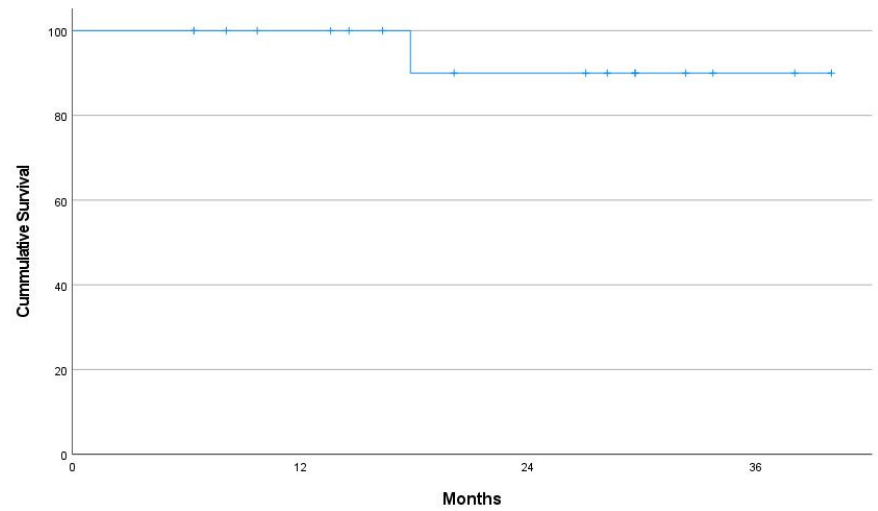
Figure 4. Kaplan–Meier curves for local progression-free survival of 17 eyes.